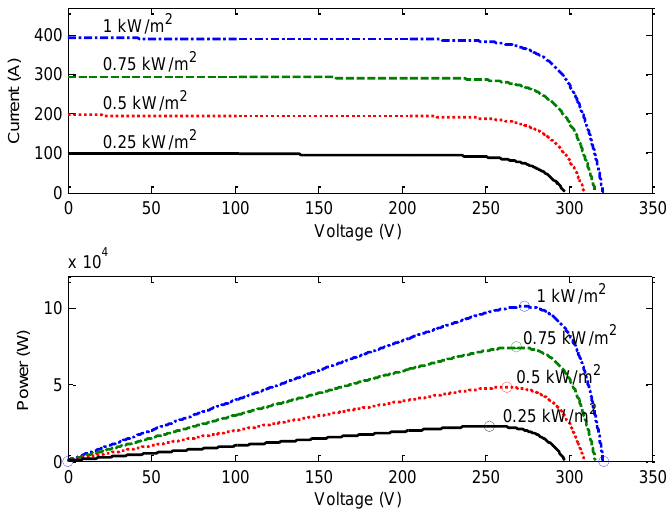
Figure 6. I - V and P - V characteristics of the PV array model used in the simulation analysis.